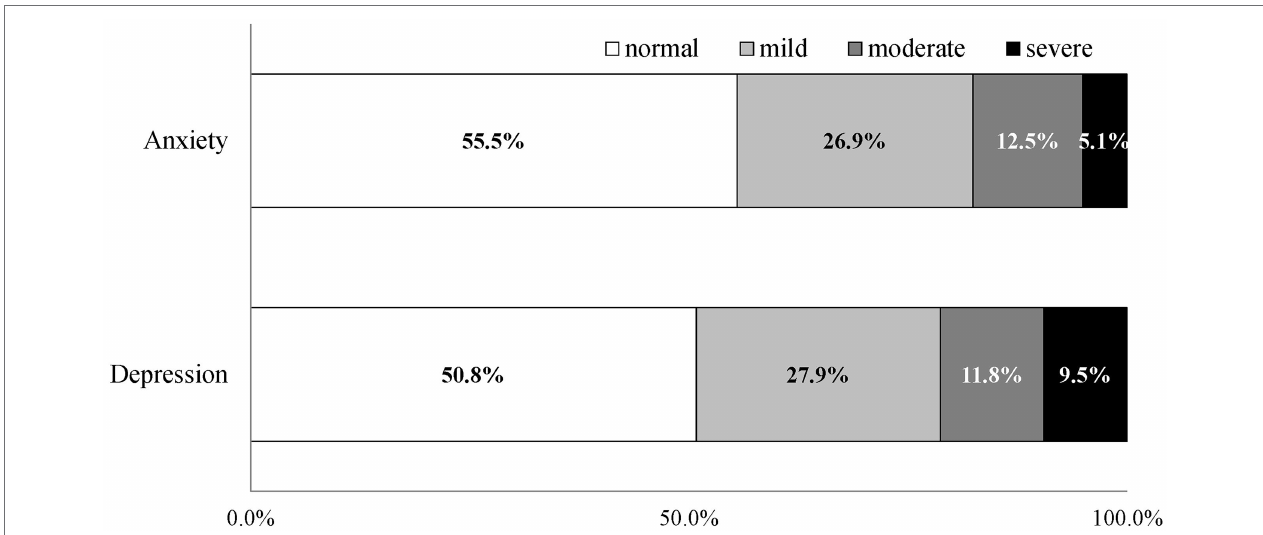
FIGURE 1 | Stacked bar charts showing the severity of anxiety and depression of the adult, working-age population in Mainland China at the early remission stage of the COVID-19